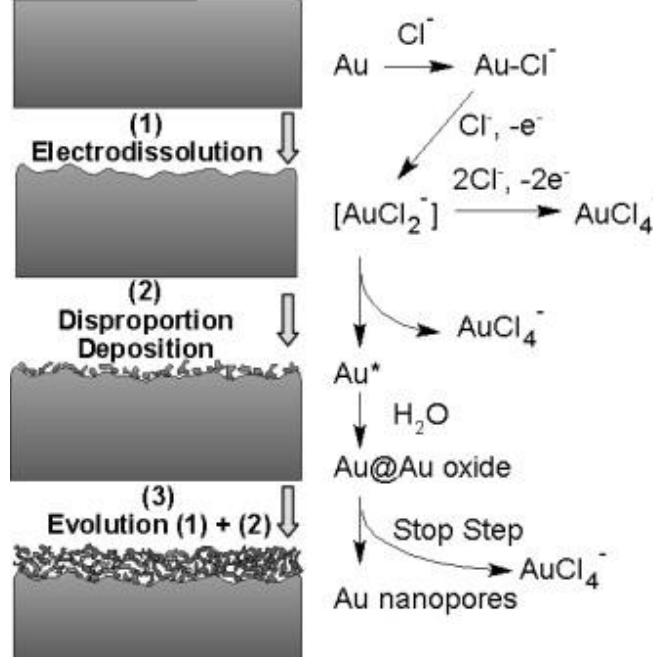
Figure 3. Schematic illustration of the fabrication principle of nanoporous gold films. Reprinted with permission from [64]. Copyright 2008,